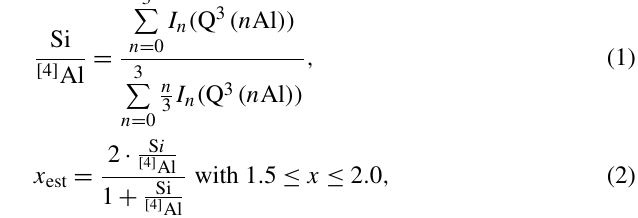
Figure 6. Lattice metric of the polytype 2M 1 of selected lepidolite and Li-muscovite samples adapted from Table S1. The error mar- gins are less than the width of the data symbols.